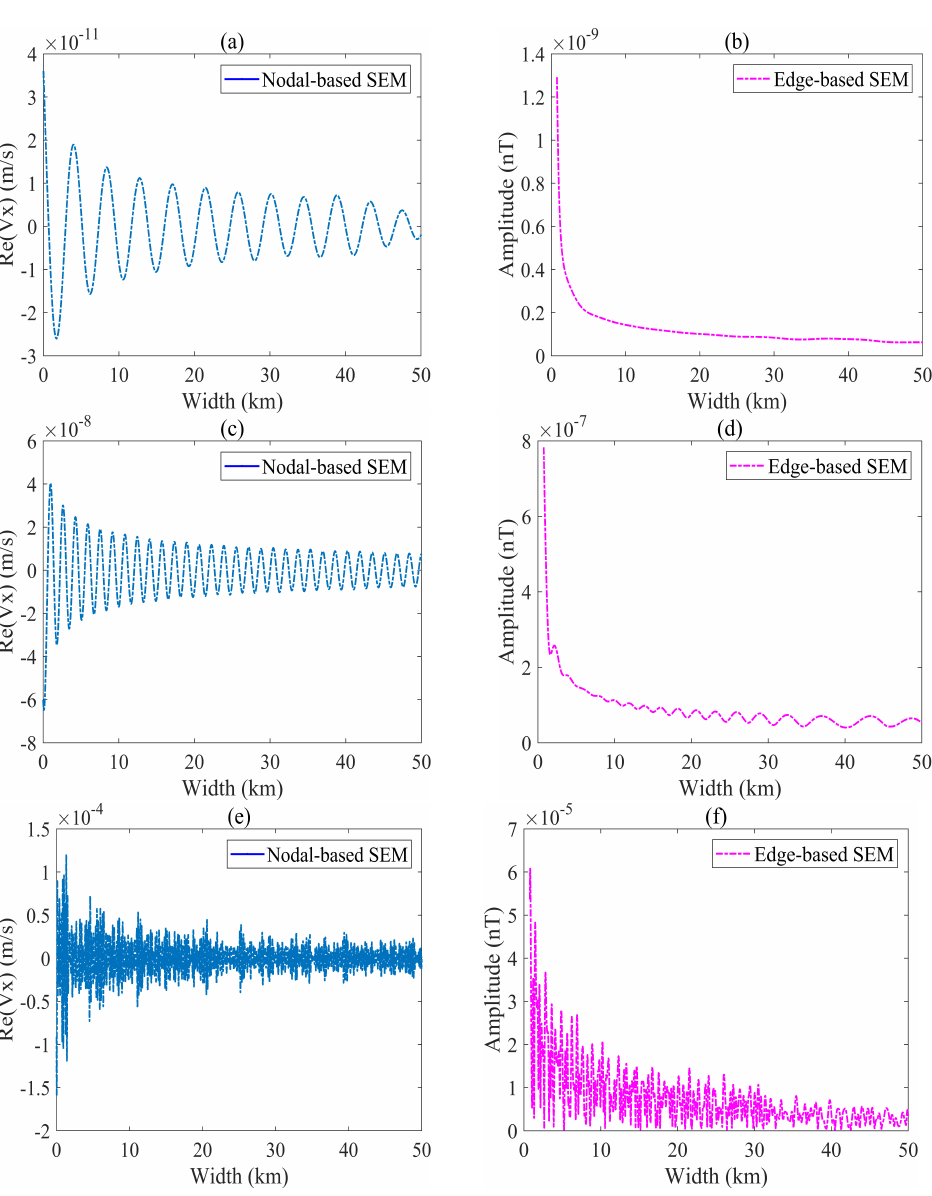
Figure 6. Velocities (300 m underwater) and magnetic fields (100 m above the sea) induced by different pressure waves. ( a , b ) Velocity and magnetic field generated by a 1 Pa pressure wave located at 100 m underwater with a frequency of 0.5 Hz. ( c , d ) Velocity and magnetic field generated by a 1 kPa pressure wave located at 200 m underwater with frequency of 1 Hz. ( e , f ) Velocity and magnetic field generated by a 1 MPa pressure wave located at 500 m underwater with frequency of 10